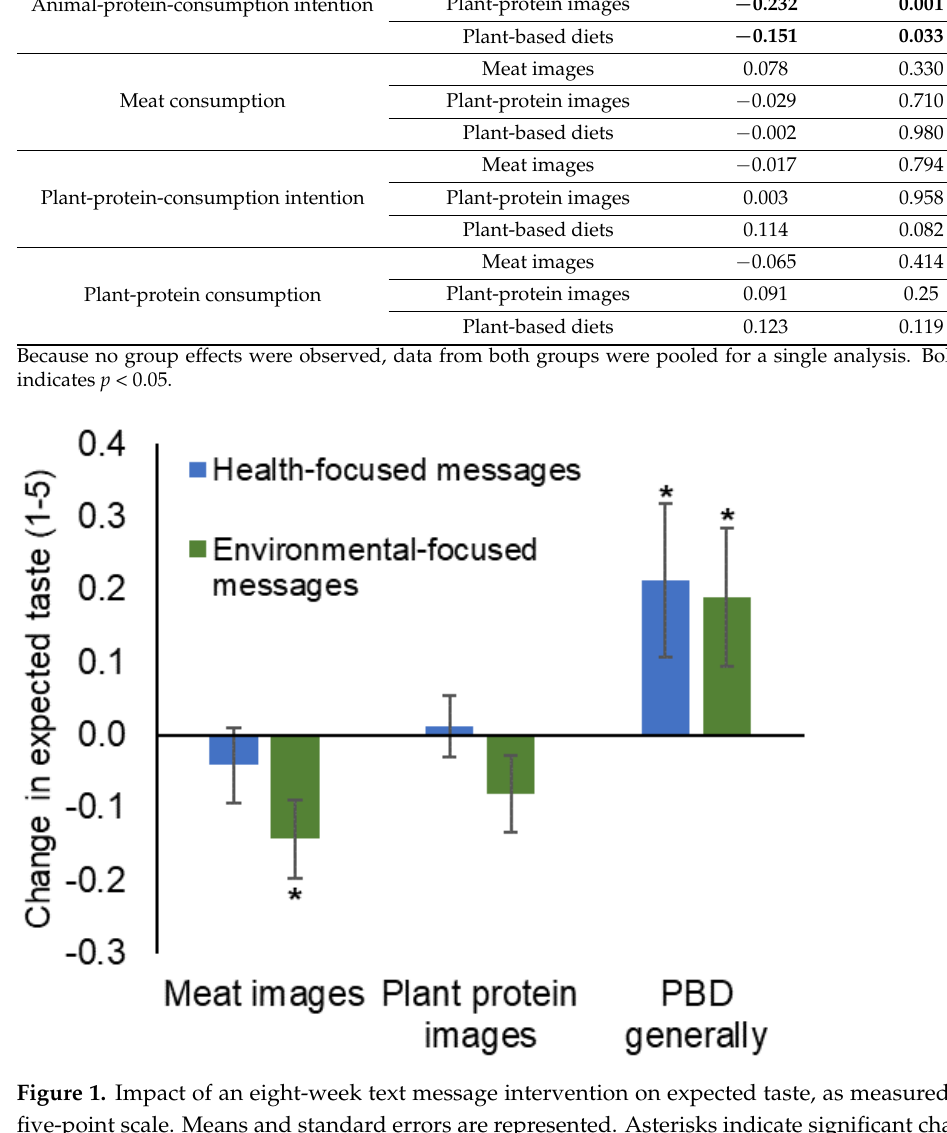
Table 4. Influence of baseline person-related factors on changes in expected taste following the text message intervention.